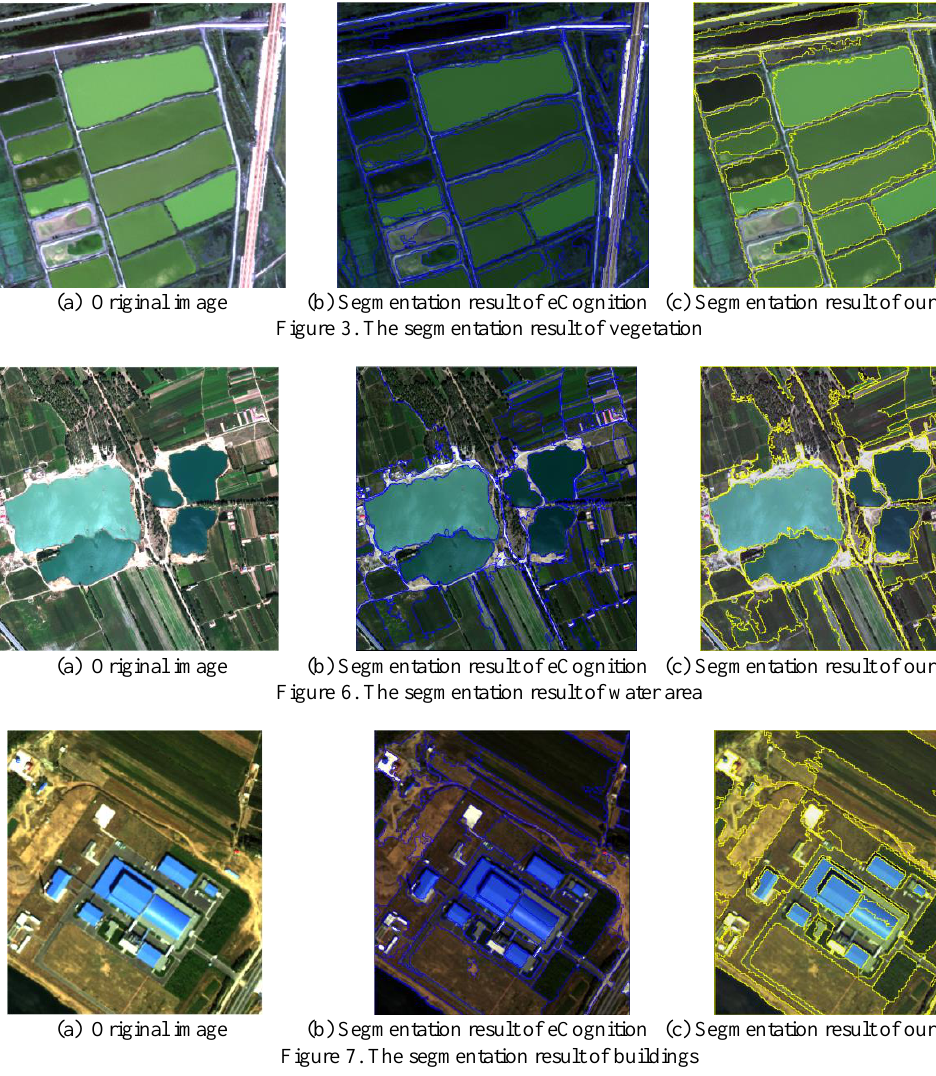
Figure 7. The segmentation result of